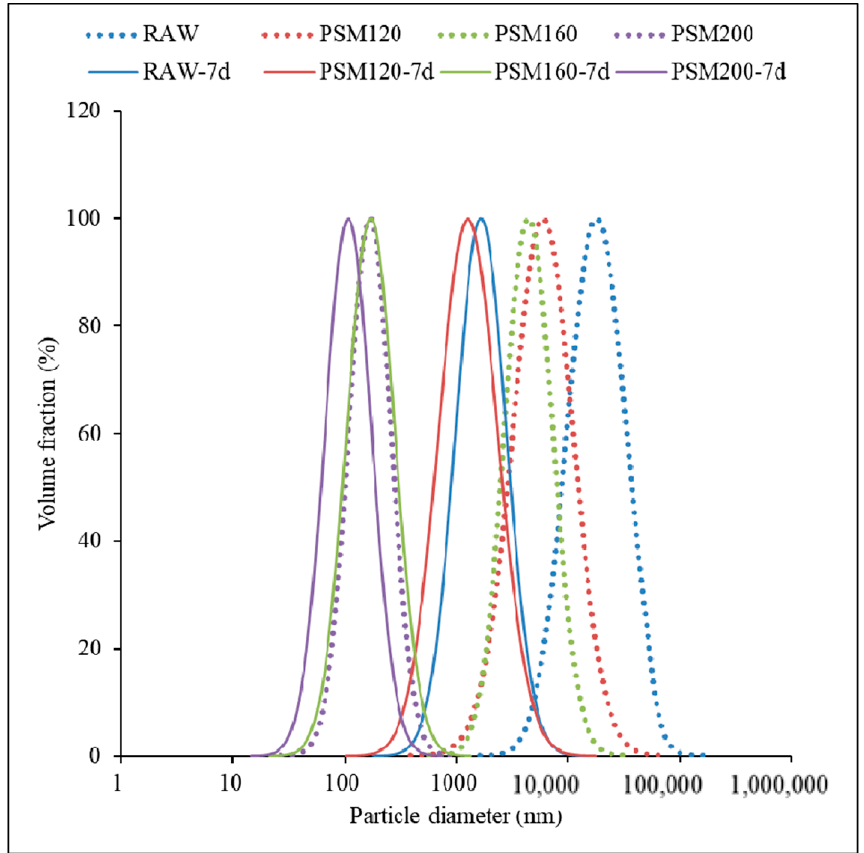
Figure 3. Particle size of pumpkin seed milk prepared with different pumpkin seeds. RAW: raw pumpkin seeds, PSM120: pumpkin seeds roasted at 120 °C, PSM160: pumpkin seeds roasted at 160 °C, and PSM200: pumpkin seeds roasted at 200 °C. Solid line: fresh pumpkin milk; dotted line: pumpkin milk stored at 20 °C for 7 days.